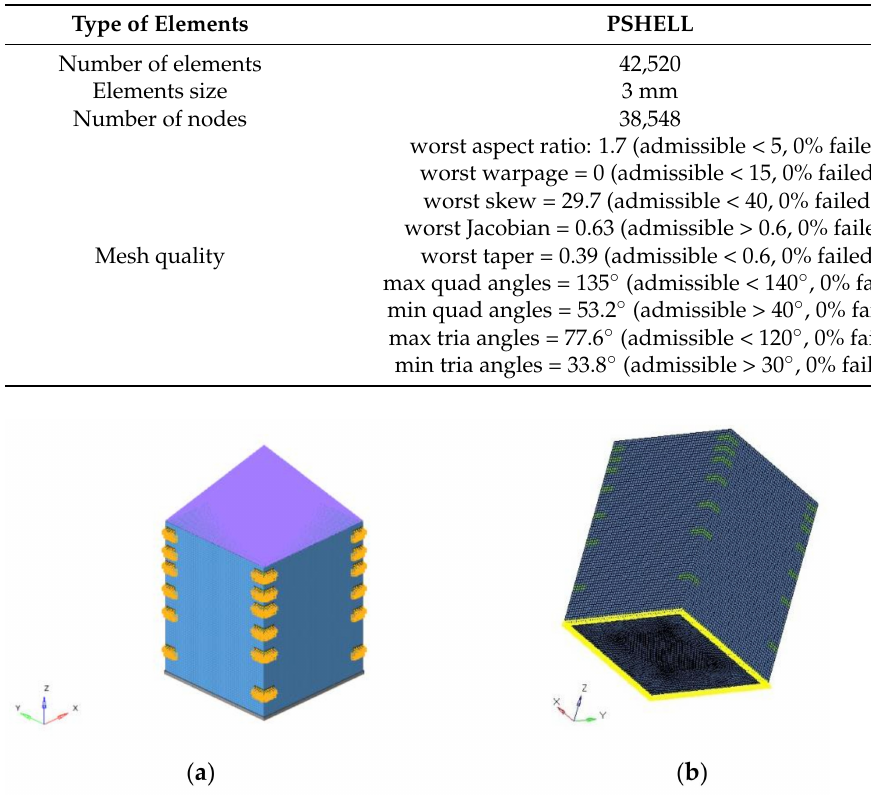
Table 5. Mesh details.